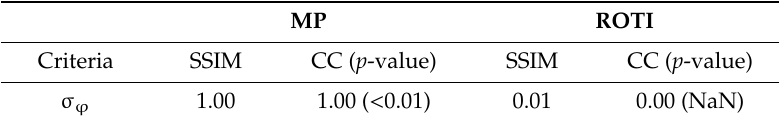
Table 18. SSIM and CC between the maps shown in Figure 16a.